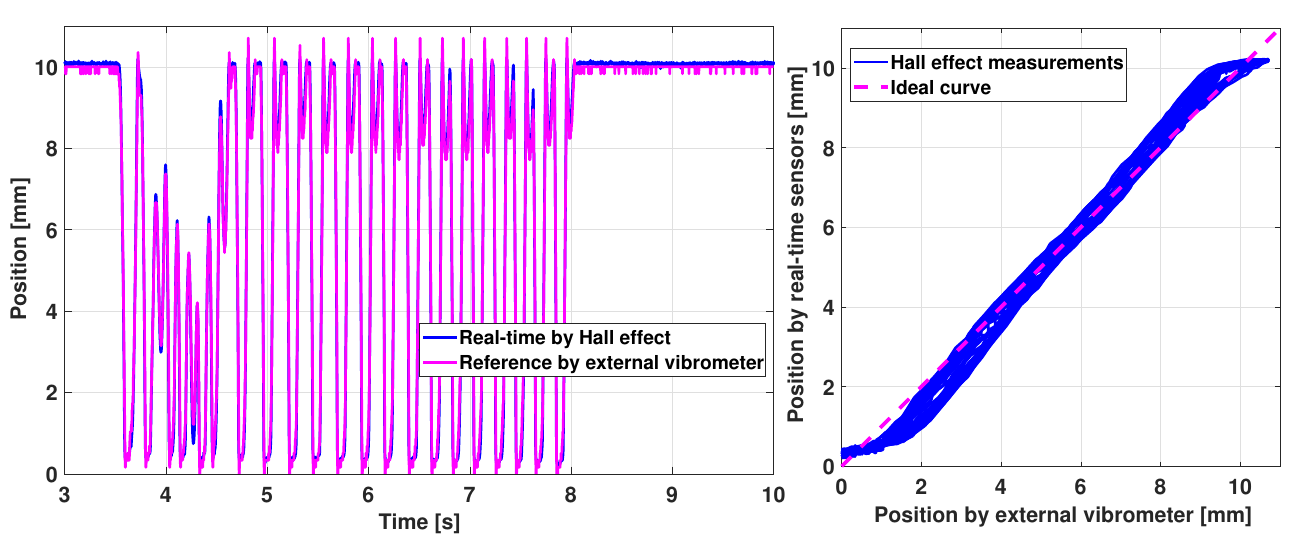
Figure 20. Haptic key validation of position sensors: fast motion.